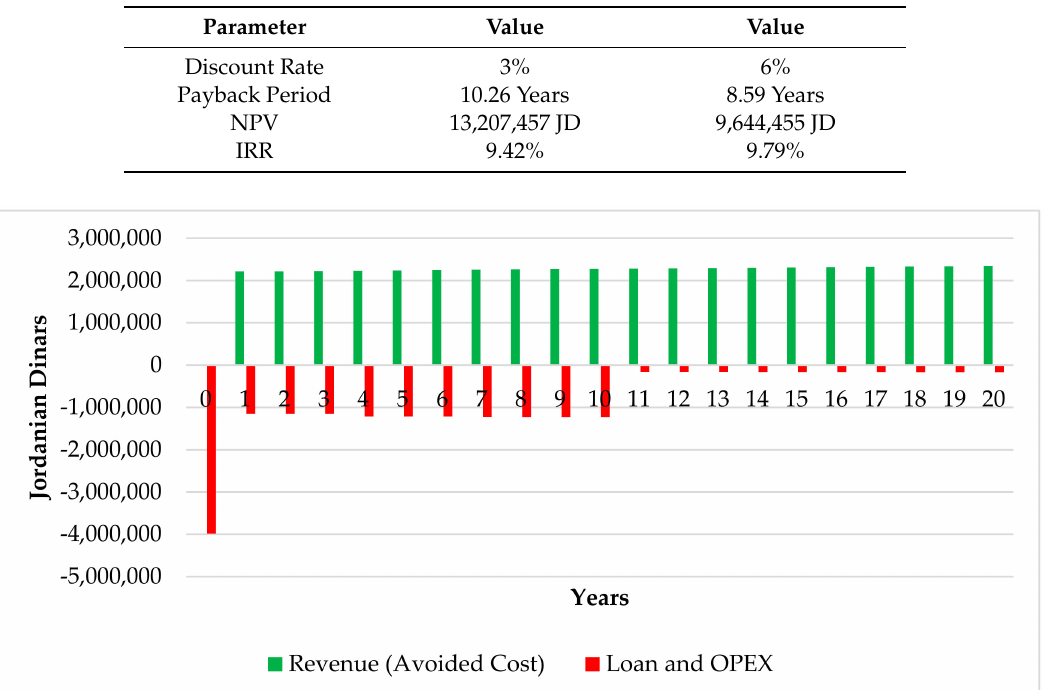
Figure 17. Cash flow diagram for KTD’s hybrid